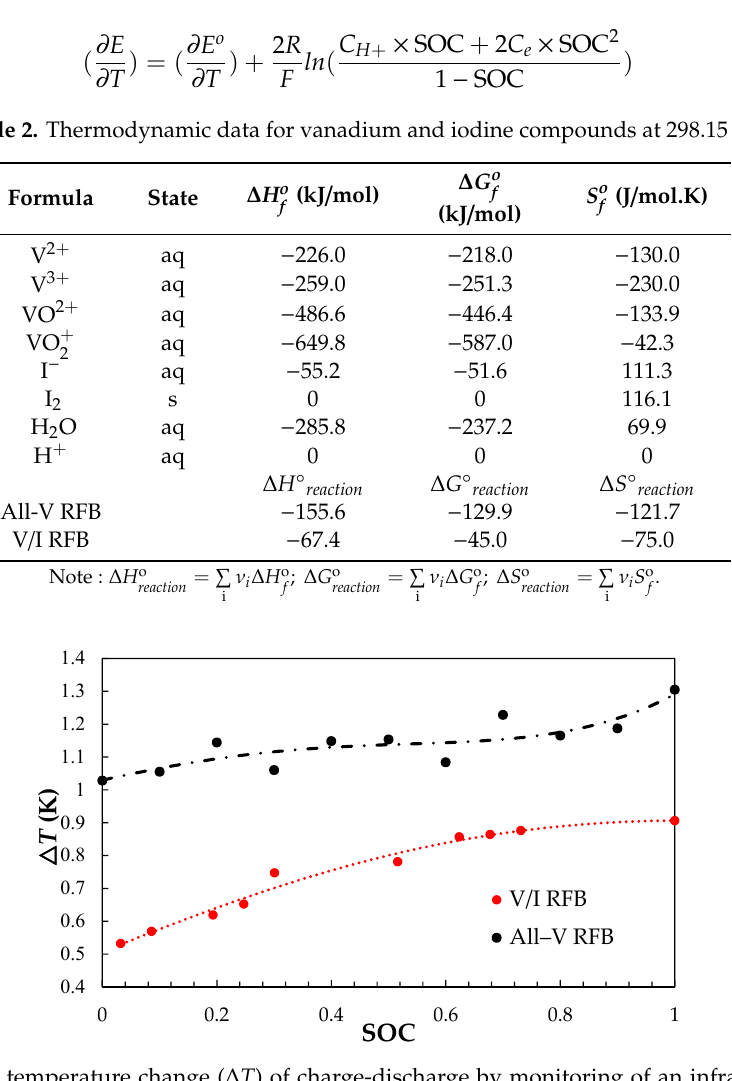
( b ) Figure 4. Measured ( ∂ E / ∂ T ) by monitoring of the ITI compared to calculate ∂ E / ∂ T as a function of the SOC for ( a ) an all-V RFB and ( b ) a V/I RFB.